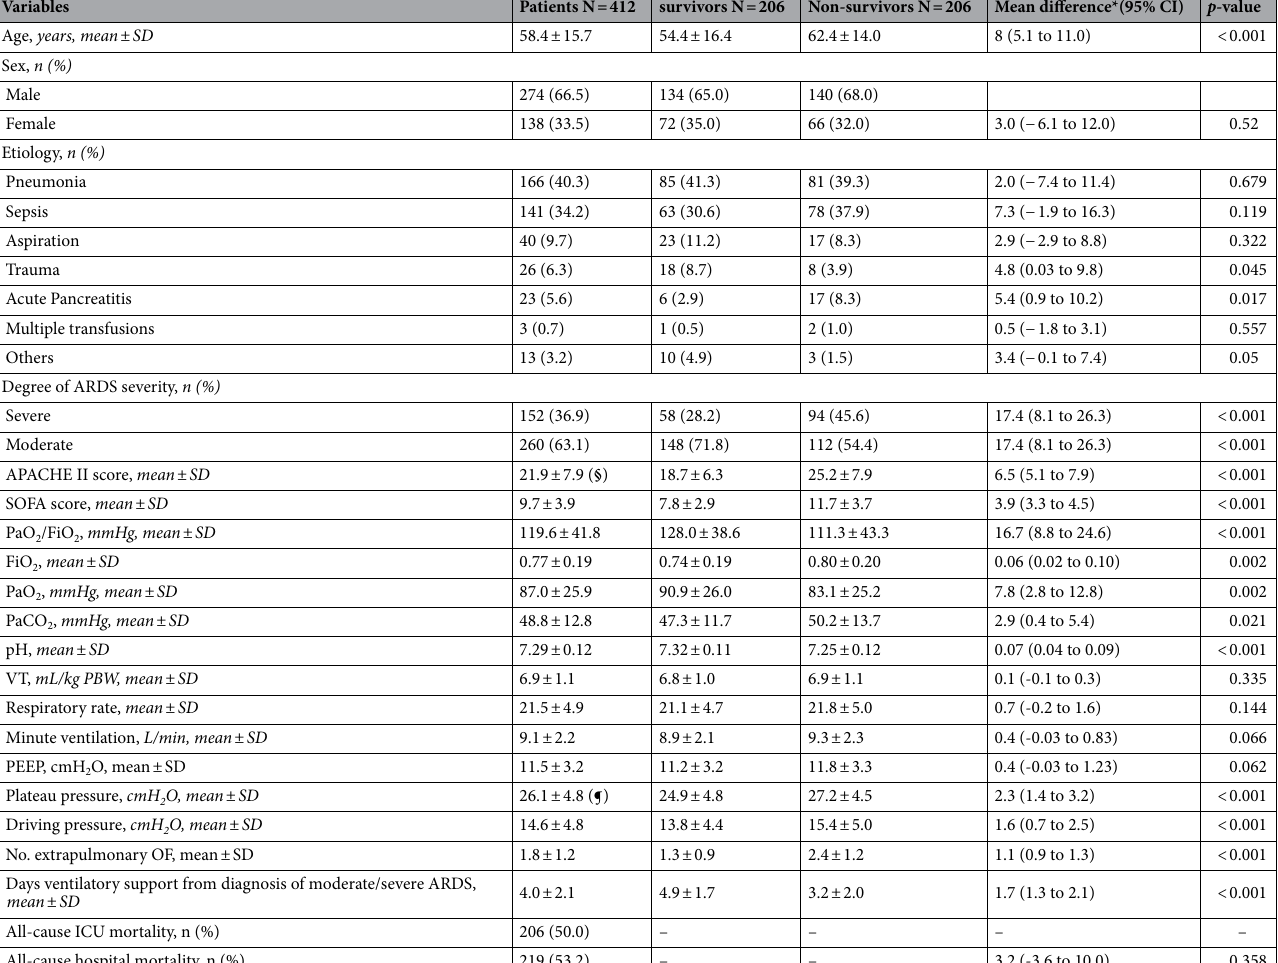
Table 2. Baseline characteristics and outcome data of 412 patients with moderate-to-severe acute respiratory distress syndrome. Number of patients represents the cumulative number of patients on ventilatory support for ≤ 7 days and discharged dead or alive from ICU. (*) Mean difference represents the difference between values in survivors and non-survivors. APACHE, acute physiology and chronic health evaluation; ARDS, acute respiratory distress syndrome; CI, confidence interval; FiO 2 , fraction of inspired oxygen concentration; ICU, intensive care unit; OF, organ failure; PBW, predicted body weight; PEEP, positive end-expiratory pressure; SD, standard deviation; SOFA, sequential organ failure assessment scale; VT, tidal volume. (§) APACHE II was missing in 4 survivors and 4 non-survivors. (¶) Plateau pressure was missing in 1